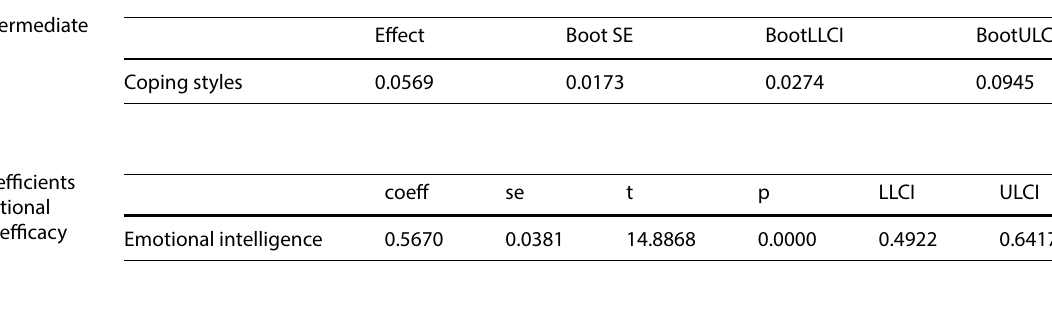
Table 4 Model fit